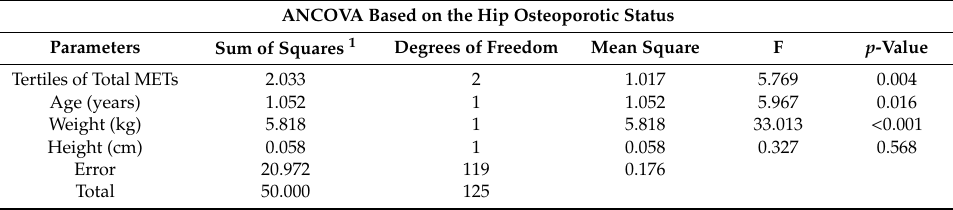
Table 2. Summary of ANCOVA according to hip osteoporotic status.